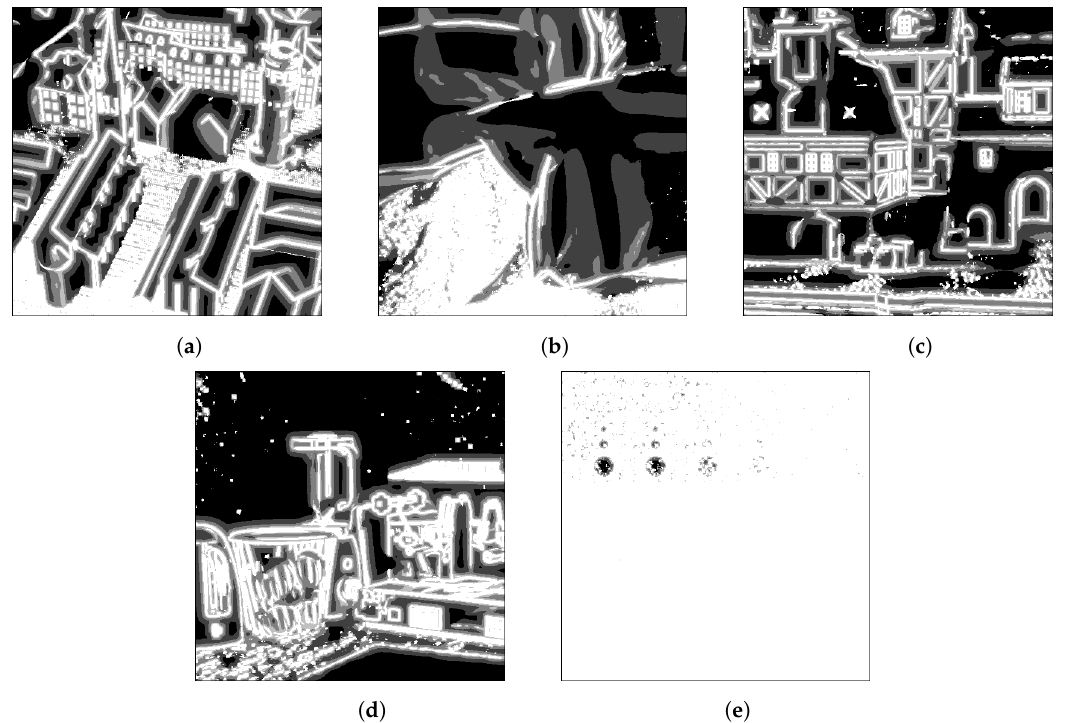
Figure 3. Illustration of the window size selection per pixel for five LF images from [43]: ( a ) town , ( b ) pillows , ( c ) medieval2 , ( d ) kitchen and ( e ) dots . The smallest windows are marked in white and the largest ones in